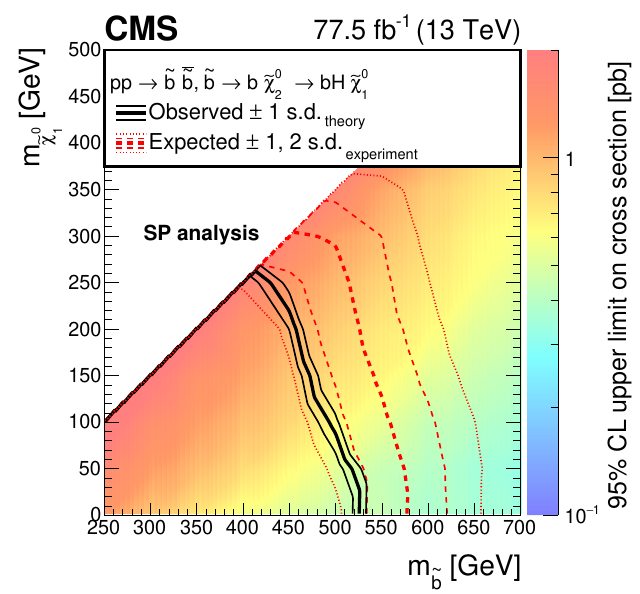
Figure 3 . The observed 95% CL upper limits on the bottom squark pair production cross section are shown for the SP analysis. The bold and light solid black contours represent the observed exclusion region and the (cid:6) 1 standard deviation (s.d.) band, including both experimental and theoretical uncertainties. The analogous red dotted contours represent the expected exclusion region and its (cid:6) 1 and (cid:6) 2 s.d.